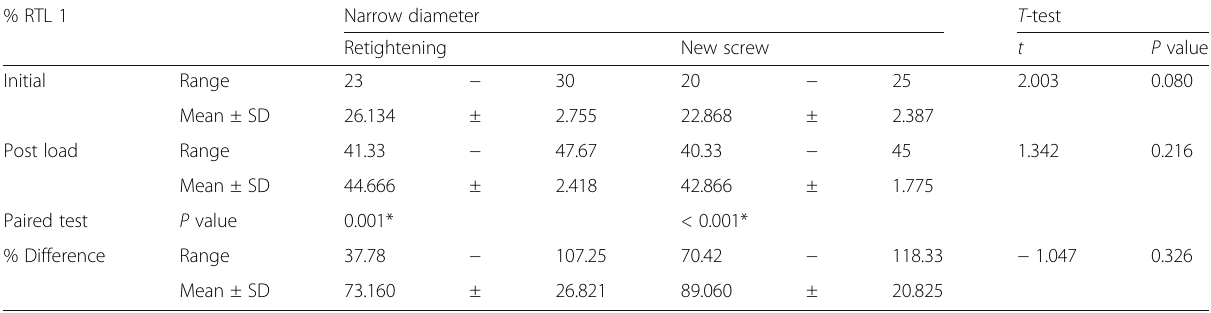
Table 5 Mean ± SD of percentage initial and percentage post load RTL 1 and percentage difference between initial and post load RTL 1 for GIIA and GIIB